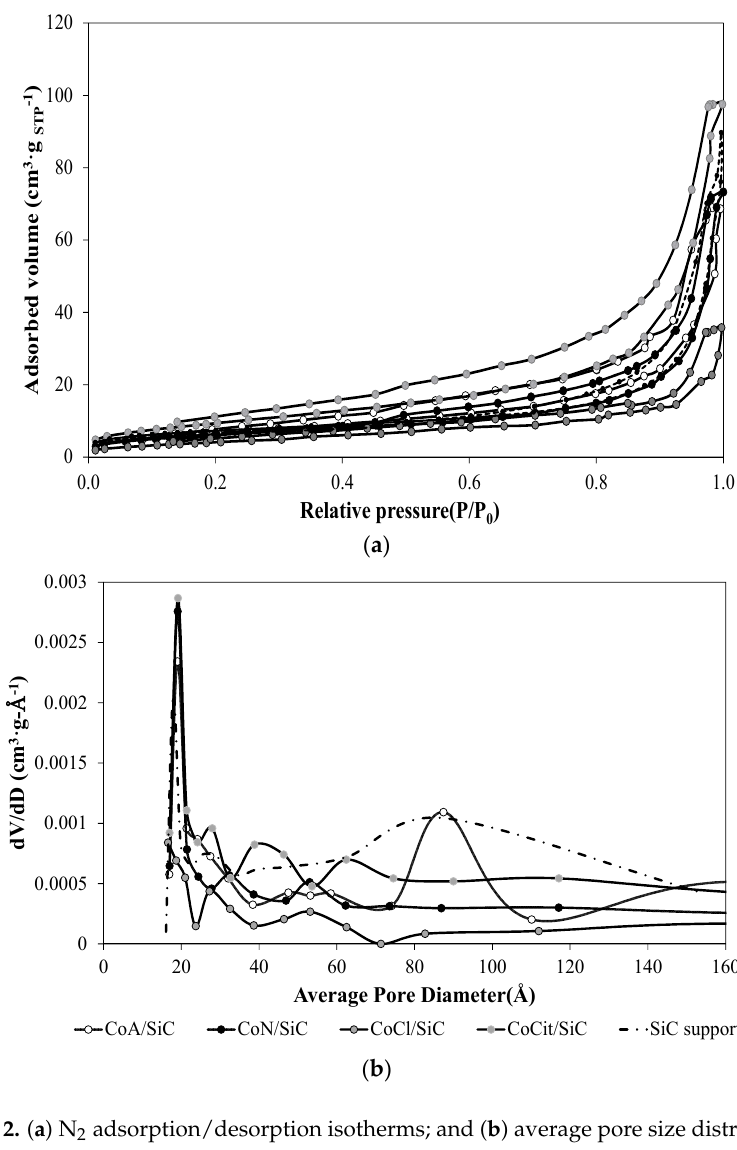
Figure 2. ( a ) N 2 adsorption/desorption isotherms; and ( b ) average pore size distribution.